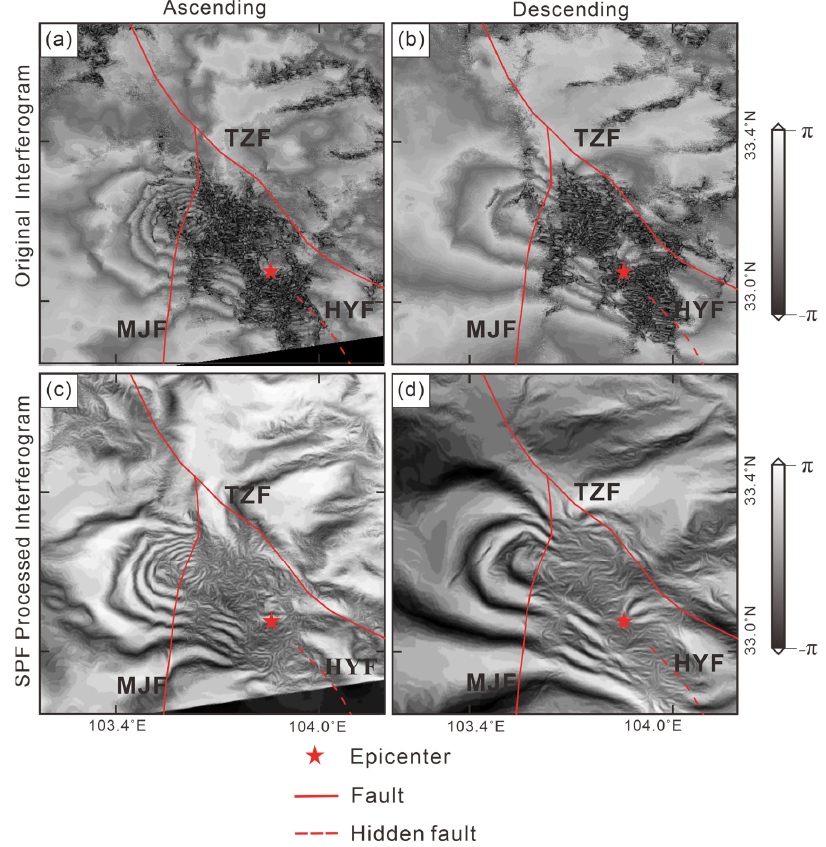
Figure 7. Original interferogram and SPF processing on the interferogram. Panels ( a ) and ( b ) are original interferogram image in grayscale of InSAR along ascending and descending orbits, respectively; ( c ) and ( d ) represent interferogram images after SPF processed along ascending and descending orbits, respectively.